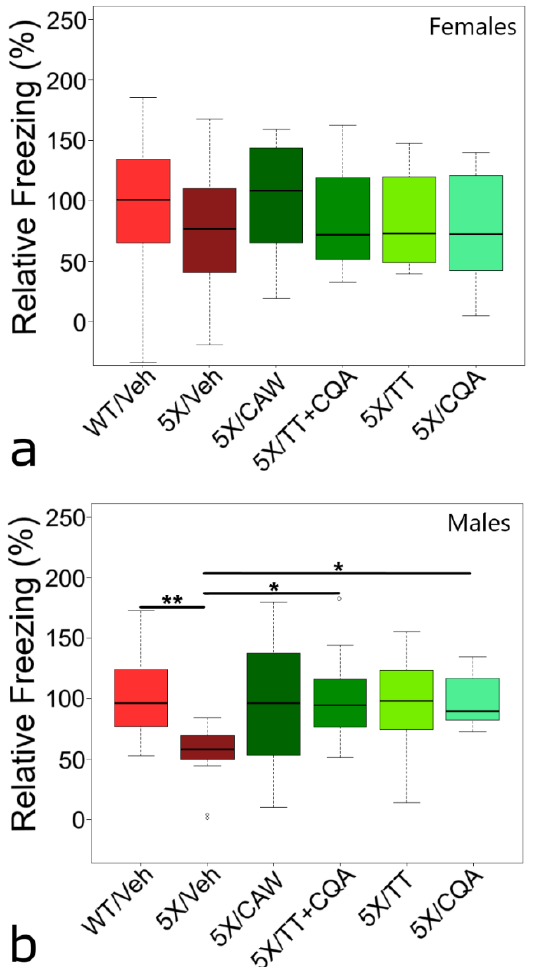
Figure 1. Conditioned fear memory evaluation of 5XFAD mice (5X) after treatment with Centella asiatica water extract (CAW) or CAW compounds. ( a , b ) Contextual fear response (CFR) analysis after 4 weeks of treatment being incorporated into the diet. ( a ) Neither genotype nor treatment had an impact on memory in 5XFAD females. Vehicle-treated (Veh) wild-type (WT) females froze for 141.6 ± 14.7 s and was set to 100%. ( b ) 5XFAD males demonstrated a memory deficit compared to WT males (decreased 46.8%, p = 0.005). Treatment of 5XFAD males with triterpenes (TT) + caffeoylquinic acids (CQA) ( p = 0.024) or CQA ( p = 0.039) improved memory, and treatment with CAW ( p = 0.095) and TT ( p = 0.082) had non-significant improvements. Vehicle-treated WT males froze for 131.2 ± 9.2 s and was set to 100%. Analysis of CFR data determined by ANOVA analysis, followed by Tukey post-hoc testing with * p < 0.05, ** p < 0.01. Group sizes for females ( a ) were WT control, 5XFAD control, CAW, TT + CQA, TT, CQA: n = 24, 21, 13, 12, 12, 15, and for males ( b ) were WT control, 5XFAD control, CAW, TT + CQA, TT,